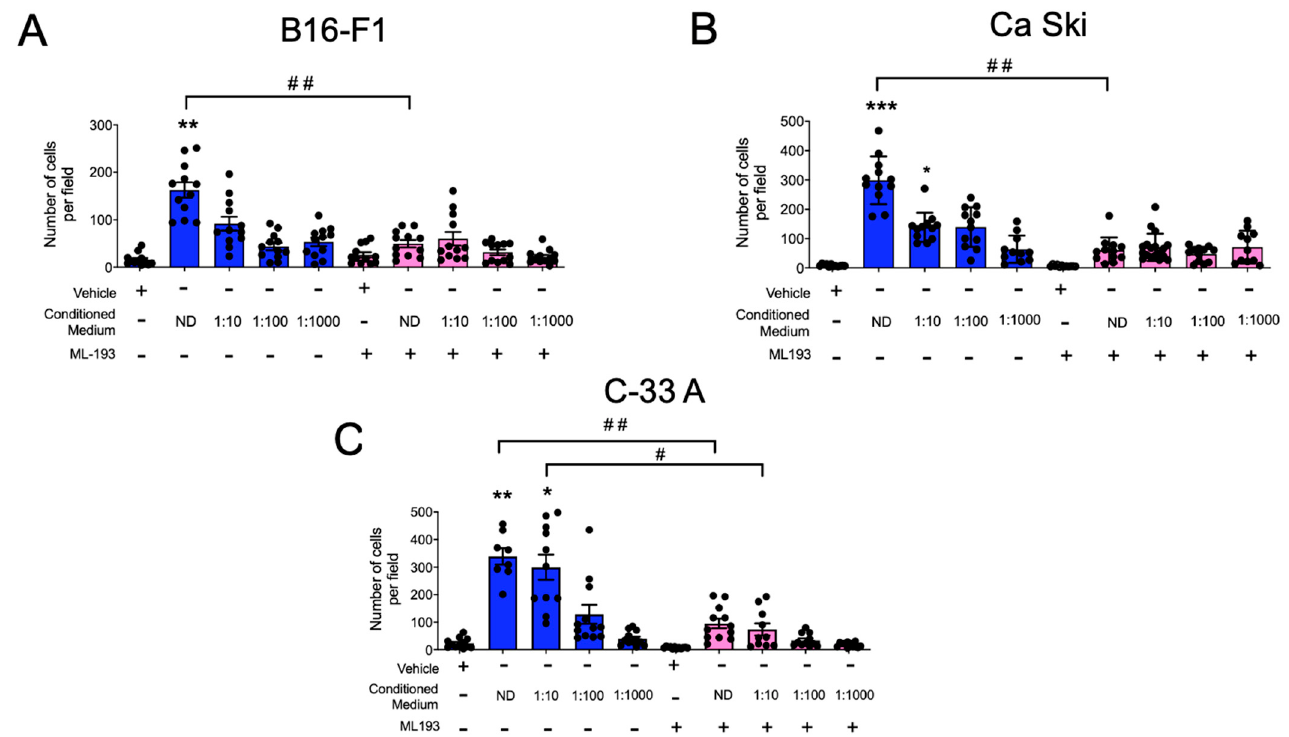
Figure 6. BMMCs migrate towards cancer cell-conditioned media in a GPR55 receptor-dependent fashion. Conditioned media from ( A ) the B16-F1 murine malignant melanoma cell line as well as ( B ) Ca Ski and ( C ) C-33 A human cervical cancer cell lines were collected and diluted as described in the Materials and Methods section. Boyden’s chamber chemotaxis experiments were performed utilizing BMMCs in the presence of vehicle or ML193 (100 nM). Data are presented as the mean ± SEM of at least four microscope fields observed with the 10X objective obtained from at least three independent experiments. One way ANOVA vs. vehicle (without ML193) values, * p < 0.05; ** p < 0.01; *** p < 0.001 vs. vehicle; # p < 0.05; ## p < 0.01 vs. ML193 non-treated groups. ND, non-diluted conditioned media. Blue and pink bars show values obtained in the absence or presence of the GPR55 antagonist ML-193, respectively.